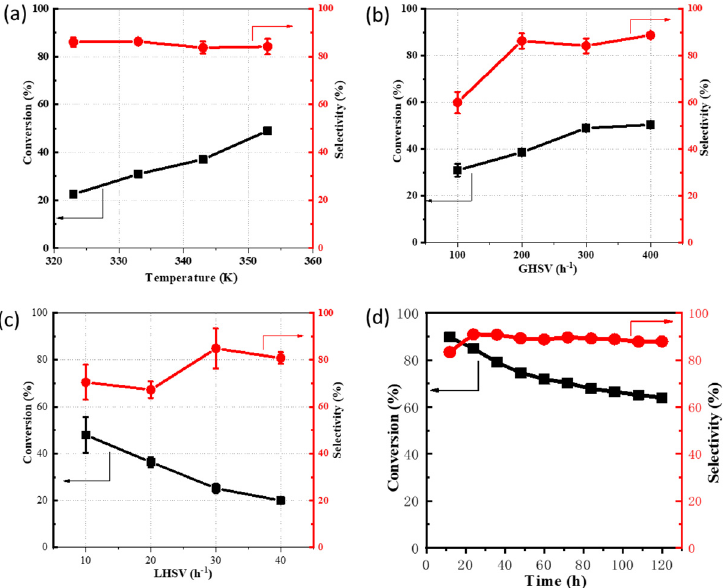
Figure 7. The oxidative esterification performances from MAL and methanol over Au 25 /ZnAl-400 catalyst as a function of ( a ) Reaction temperature at 2.1 atm O 2 , MAL/MeOH = 1/40 (molar ratio), catalyst: 0.5 g, GHSV: 3000 h − 1 , LHSV: 10 h − 1 ; ( b ) gas hourly space velocity (GHSV) at 353 K, 2.1 atm O 2 , MAL/MeOH = 1/40 (molar ratio), catalyst: 0.5 g, LHSV: 10 h − 1 , and ( c ) liquid hourly space velocity (LHSV) at 353 K, 2.1 atm O 2 , MAL/MeOH = 1/40 (molar ratio), catalyst: 0.5 g, GHSV: 3000 h − 1 ; ( d ) reaction time at 353 K, 2.1 atm O 2 , MAL/MeOH = 1/40 (molar ratio), catalyst: 0.5 g, GHSV: 3000 h − 1 , LHSV: 10 h − 1 .